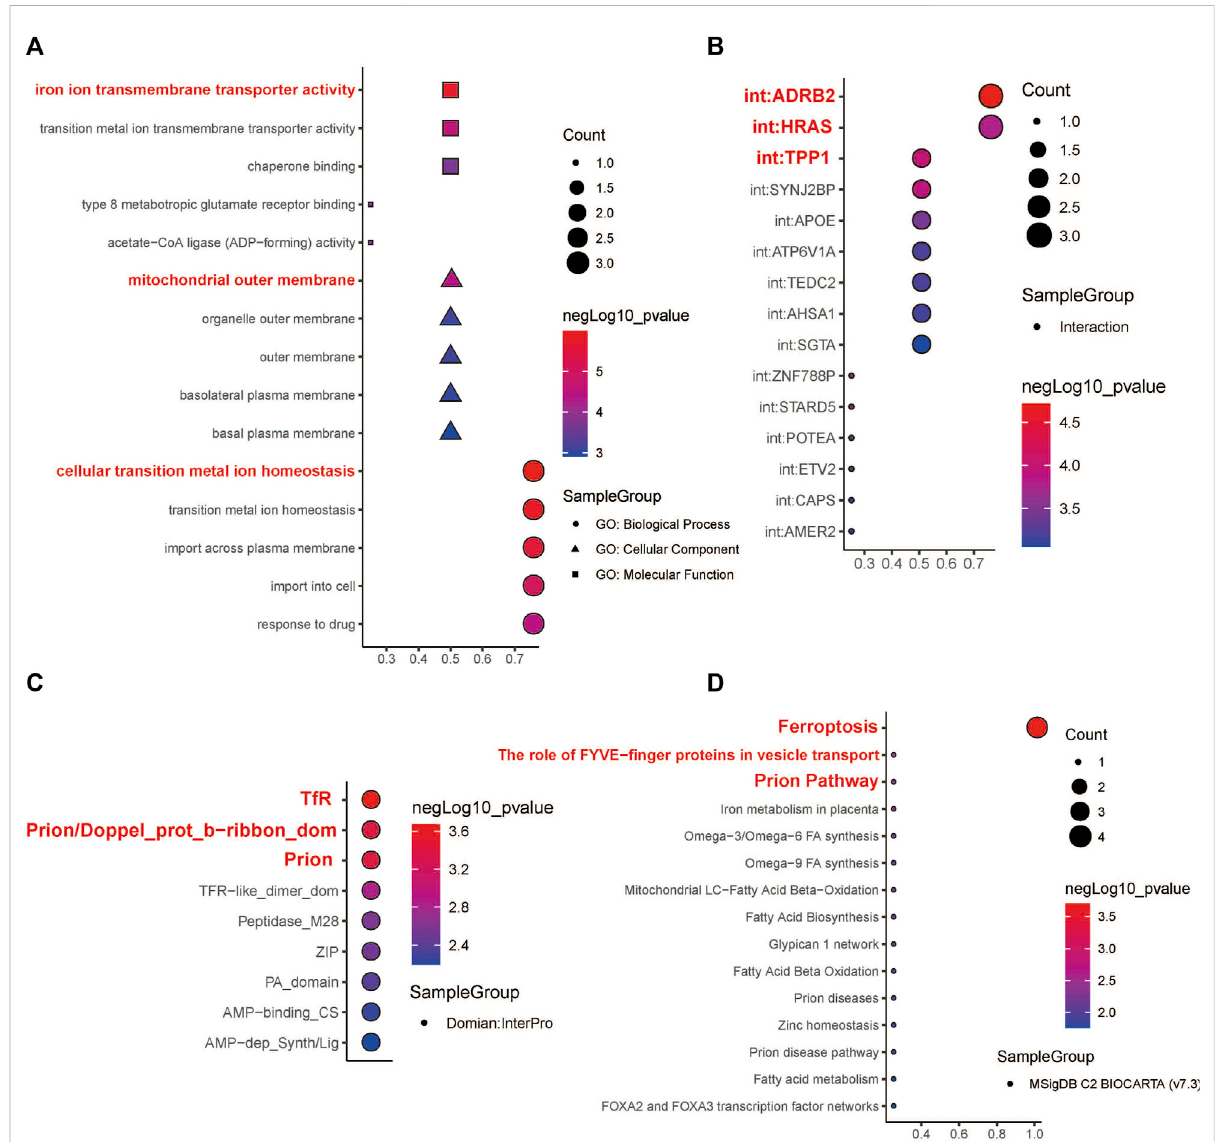
FIGURE 7 Functional enrichment analysis and molecular domain prediction of hub genes. (A) The biological process, cellular component, and molecular function that ACSL1 , SLC39A14 , TFRC , and PRNP were mainlyinvolvedin. (B) Possible interaction of ACSL1 , SLC39A14 , TFRC , and PRNP with ADRB2 , HRAS , and TPP1 . (C) Prediction of molecular domains of the hub genes. (D) Major molecular pathways through which the hub genes might participate in the progression of